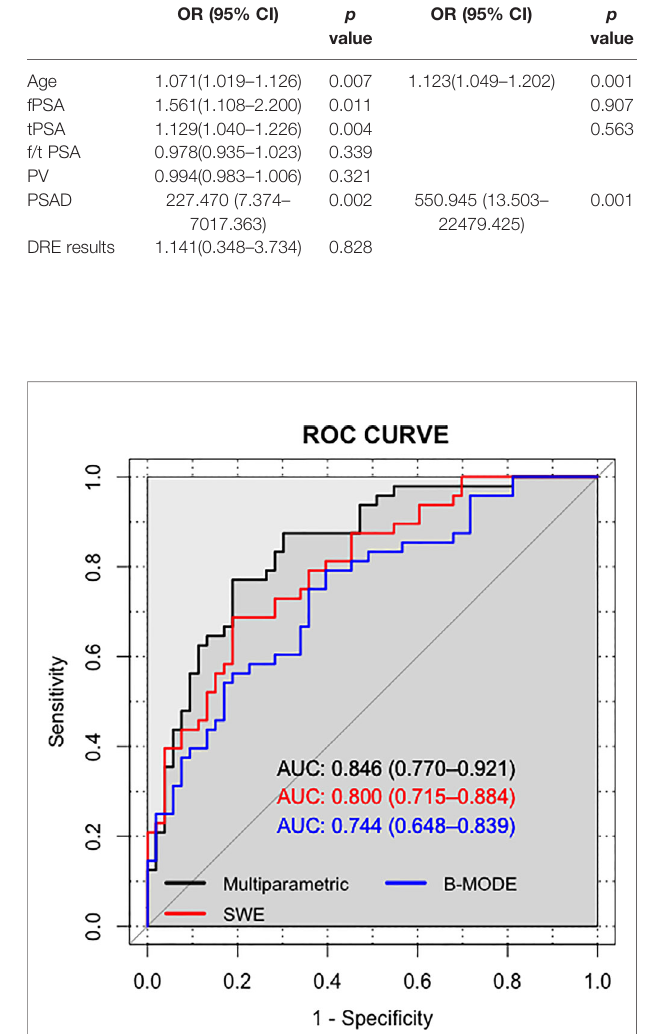
FIGURE 5 | ROC of B-mode ultrasound, SWE, and